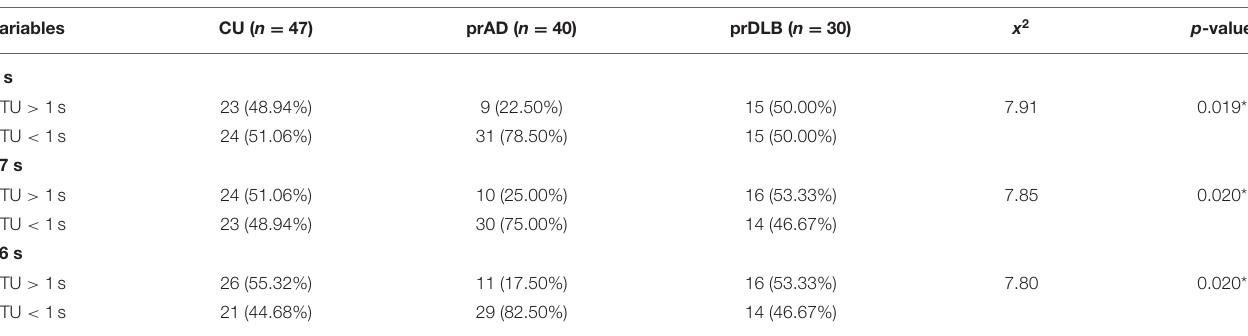
TABLE 5 | Verbal estimation test numbers of people STU lower or higher than 1s.